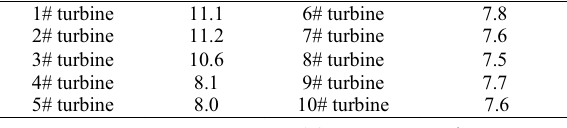
Fig.4. Optimization model of wind turbines power dispatch in wind farm